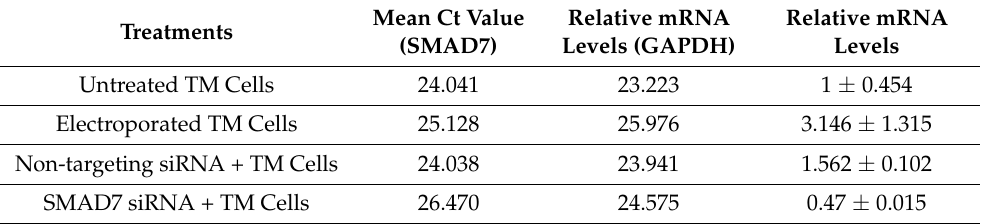
Table 3. qRT-PCR analysis of electroporated TM cells for the assessment of SMAD7 gene silencing. Treatments